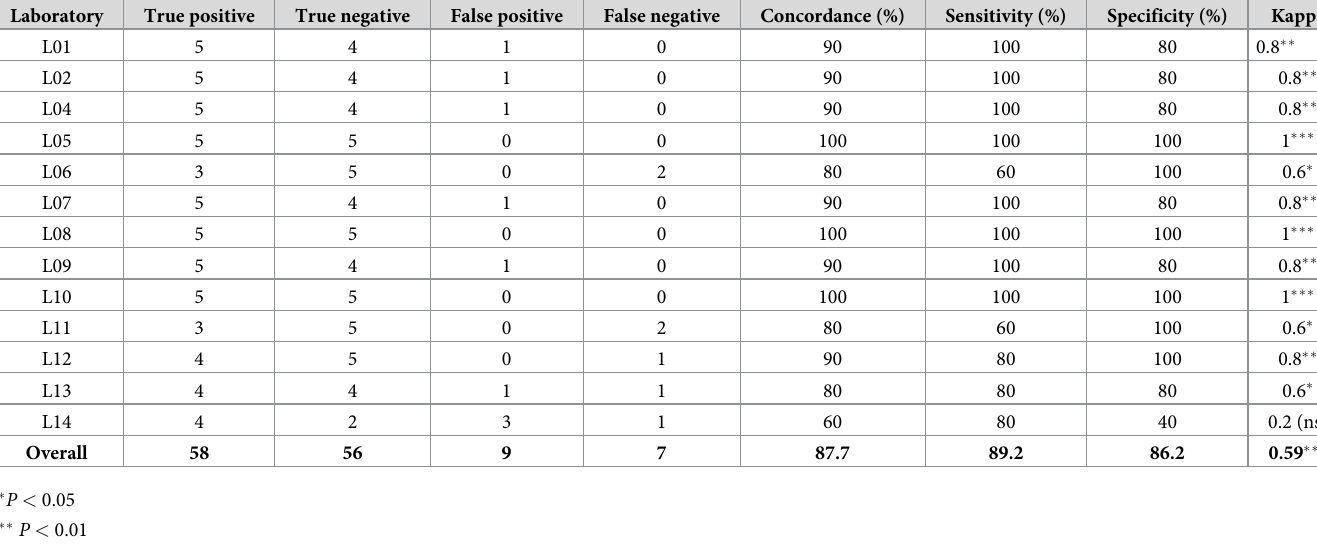
Table 2. Fluorescent antibody test results by laboratory and statistical analyses of agreement. The concordance, specificity, sensitivity and K coefficient with p-value were calculated per each laboratory. Thirteen laboratories (out of fourteen) submitted results for this part of the PT. Laboratory L03 did not submit any results by